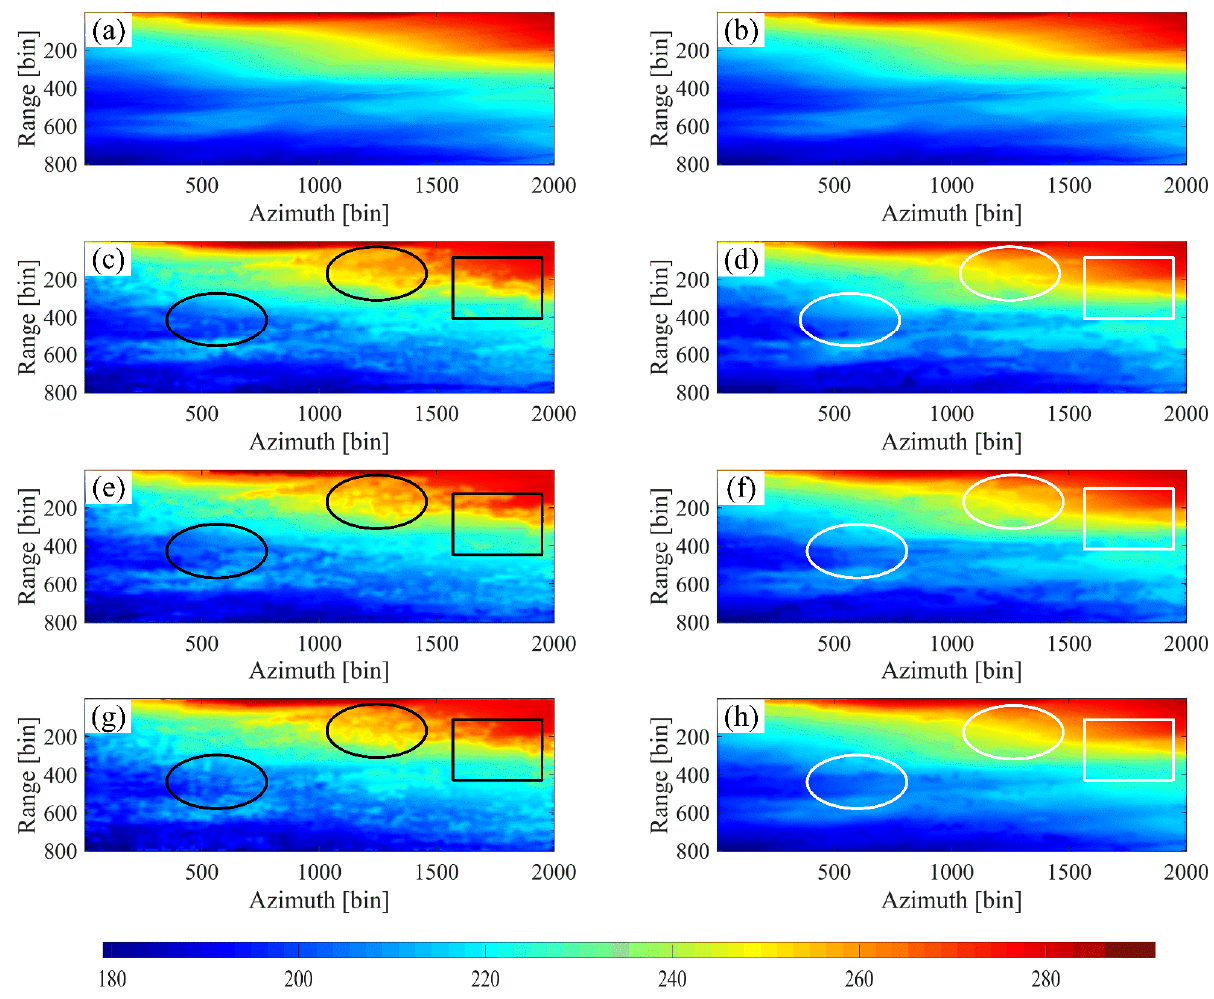
Table 6. Comparison of the RMSEs of the underlying topography inversion results.